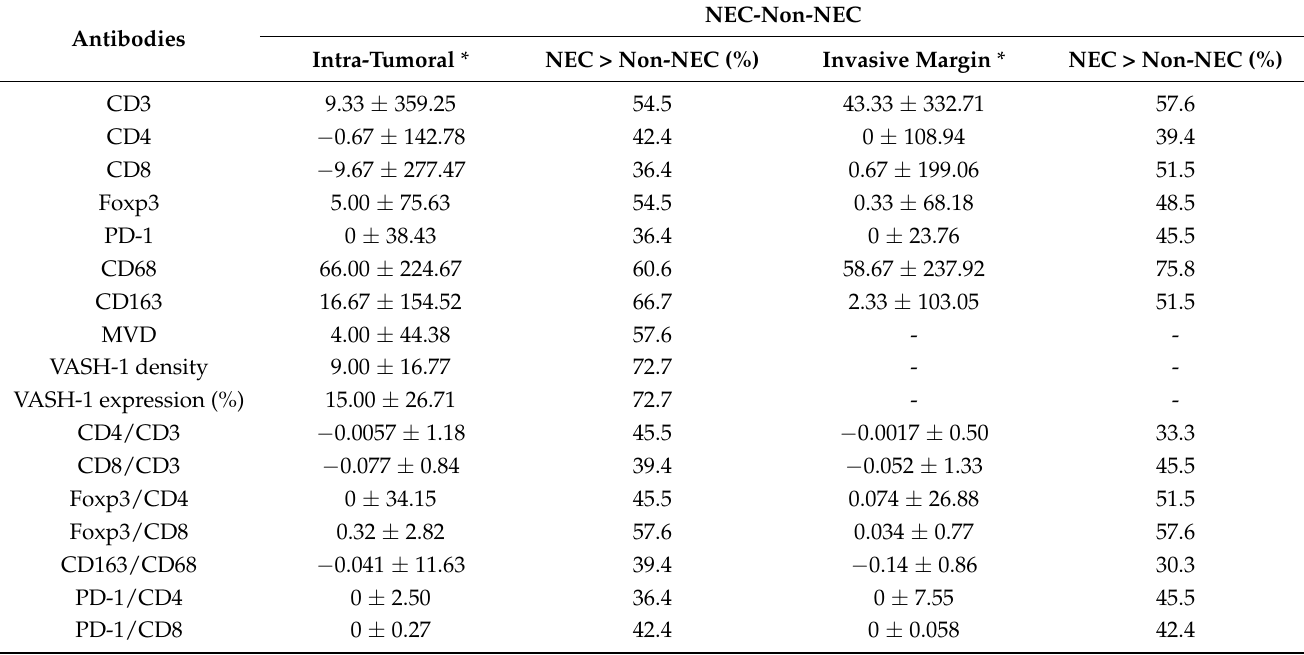
Table 3. The difference of each antibody positive lymphocytes, macrophage, and molecules for micro-vessels between NEC and non-NEC and the ratio of the cases with more positive ones in NEC than in non-NEC areas. * median ±